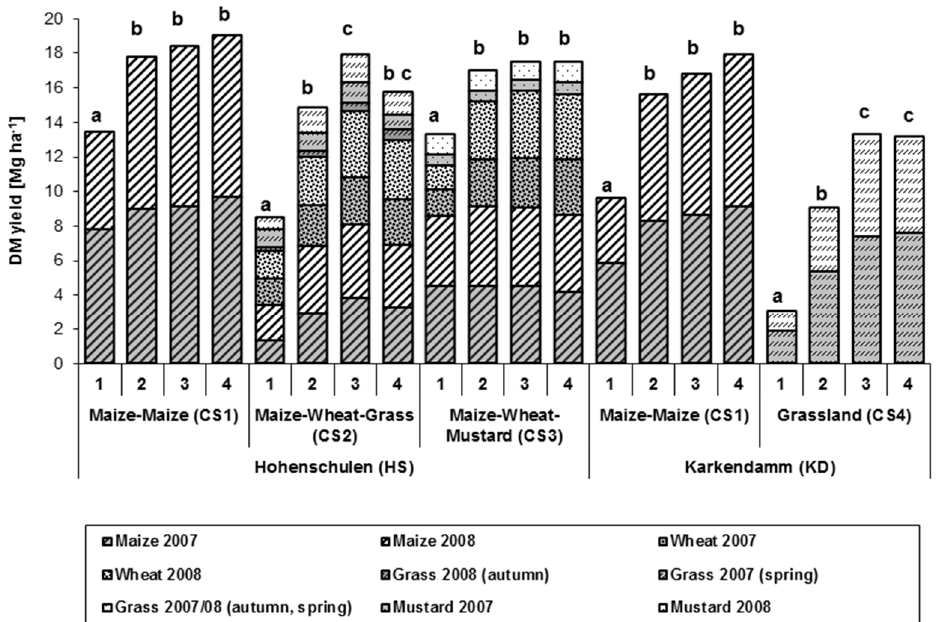
Figure 2. Dry matter (DM) yields of the different cropping systems averaged per year, indicated by the total height of each bar and given separately for the different N levels (1–4). Different signatures indicate different crops. Different colors indicate the yield proportion of the crop in each experimental year. The sum of the sub-bars with the same hatching but with different colors indicates the mean DM yield per year of each crop within a cropping system. Significant differences ( p < 0.05) between the different N treatments within a cropping system are indicated by different letters (‘a’ to